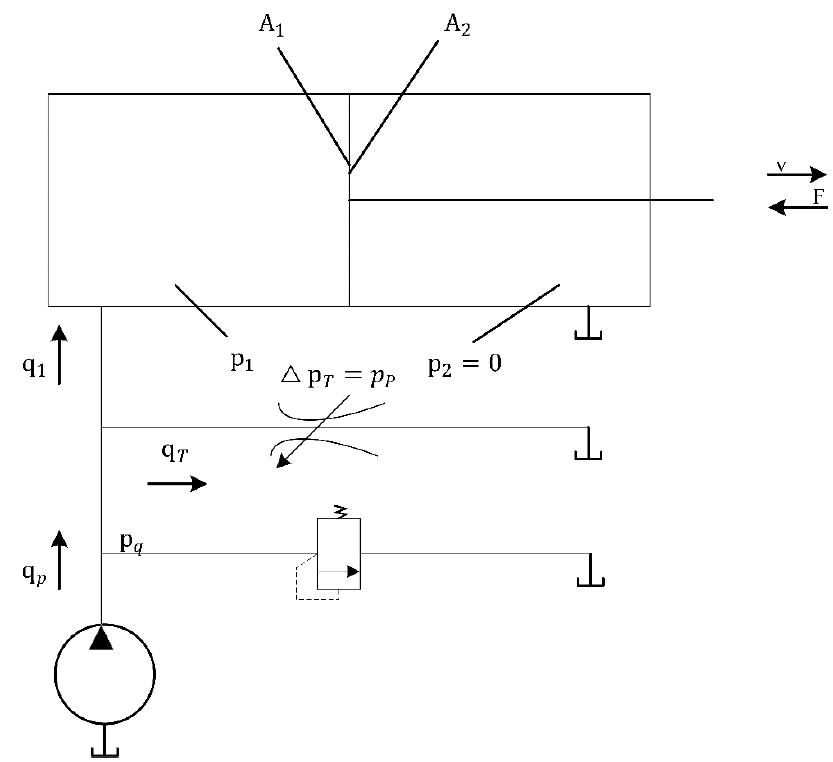
Figure 10. Schematic diagram of the throttle speed control loop.